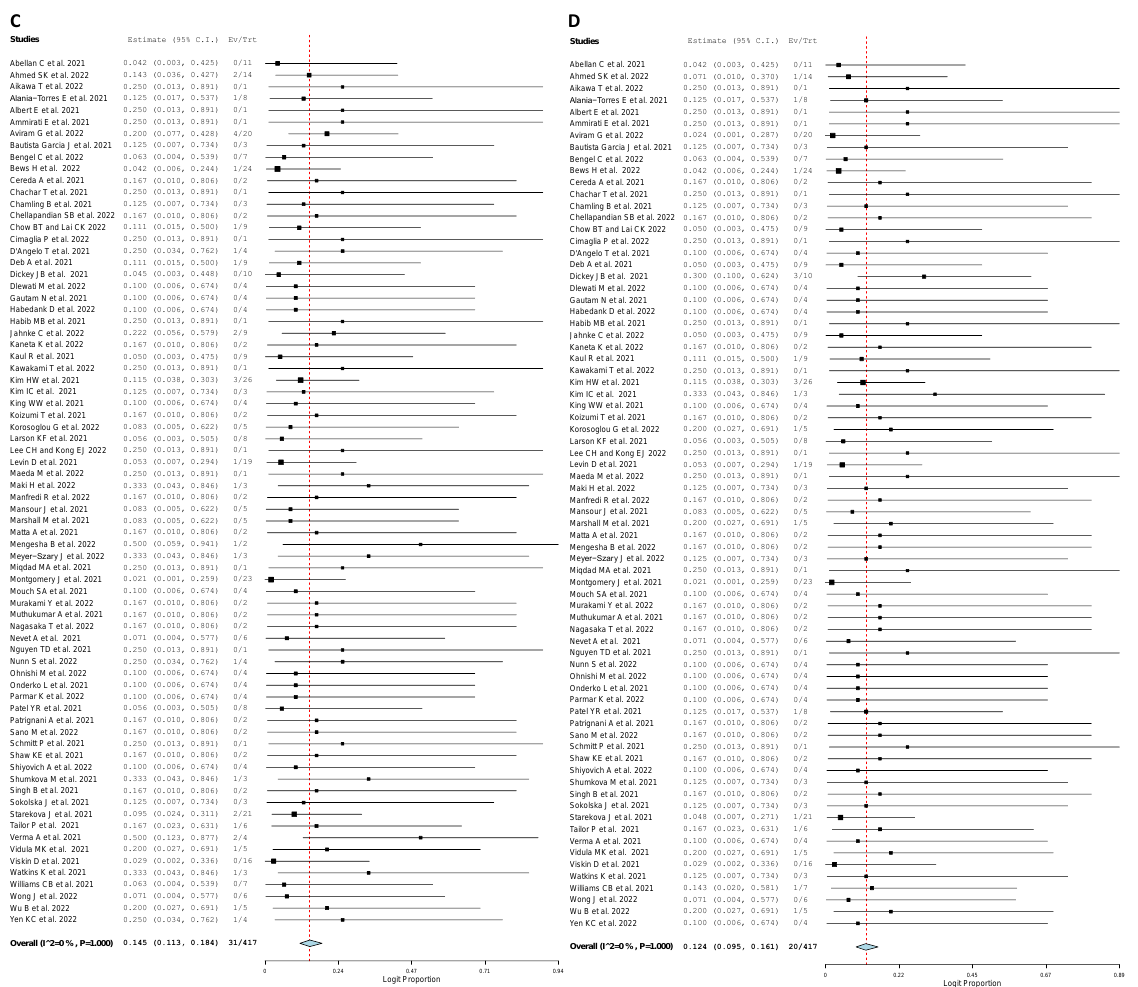
Figure 1. Forest plot of presenting symptoms. ( A ), Chest pain. ( B ), Fever. ( C ), Dyspnea. ( D ) Myalgia [16,19–92]. One hundred eighty-five ECG records were obtained at the time of admission, and a total of 188 abnormalities were reported, of which 122 were ST-related changes (58.7%; 95% CI: 0.514, 0.655; I 2 = 0%). Of the 122 ST-related changes, 96 were ST-elevations (68.8%; 95%CI: 0.605, 0.761; I 2 = 0%) (Figure 2). Moreover, twenty-two T wave changes were identified (22.5%; 95% CI: 0.172, 0.288; I 2 = 0%); likewise, twenty-three PR changes were identified (23.1%; 95% CI: 0.179, 0.292; I 2 = 0%), of which twenty PR-segment depression were identified (56.9%; 95% CI: 0.460, 0.672; I 2 = 0%) and six QRS complex changes were identified (17.3%; 95% CI: 0.127, 0.230; I 2 = 0%). Arrhythmias were identified in nineteen ECGs (21.6%; 95% CI: 0.163, 0.279; I 2 = 0%) (Figure 2). Additionally, Montgomery et al. reported 19 cases of abnormality including ST elevations, T-wave inversion, and non- specific ST